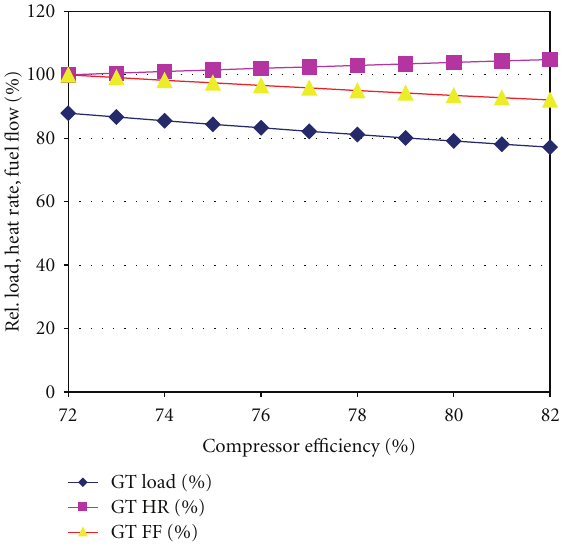
Figure 8: Impact of compressor e ffi ciency on GT Load, heat rate (HR), and fuel consumption (FF).